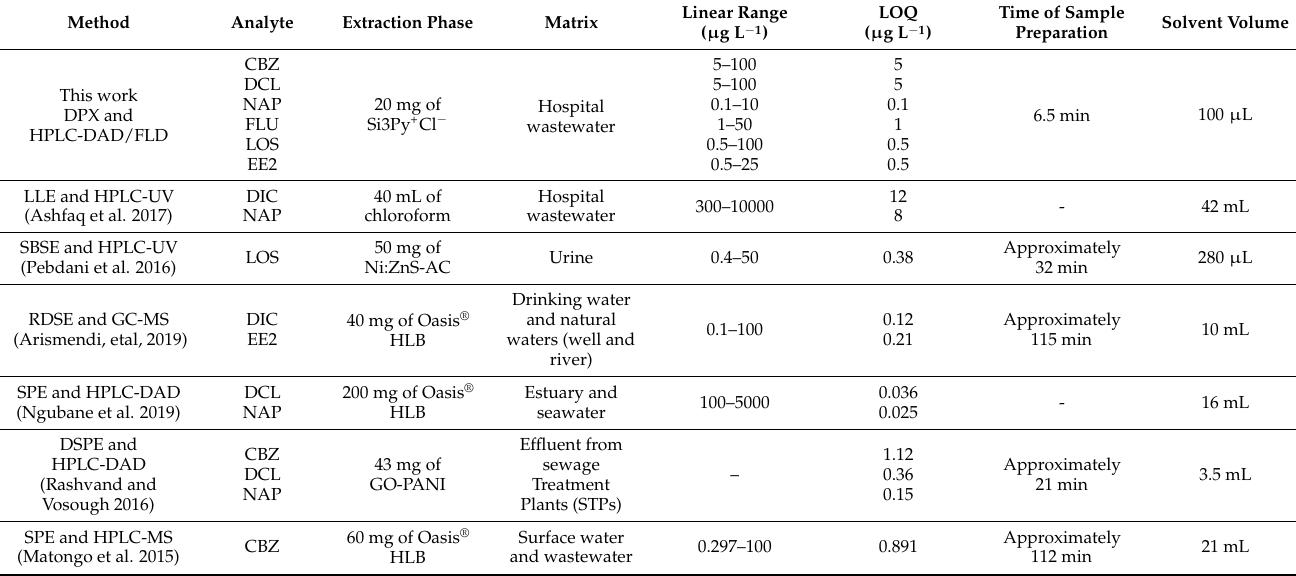
Table 4. Comparison of Si3Py + Cl − -DPX-based procedure with methods previously reported in literature. Method